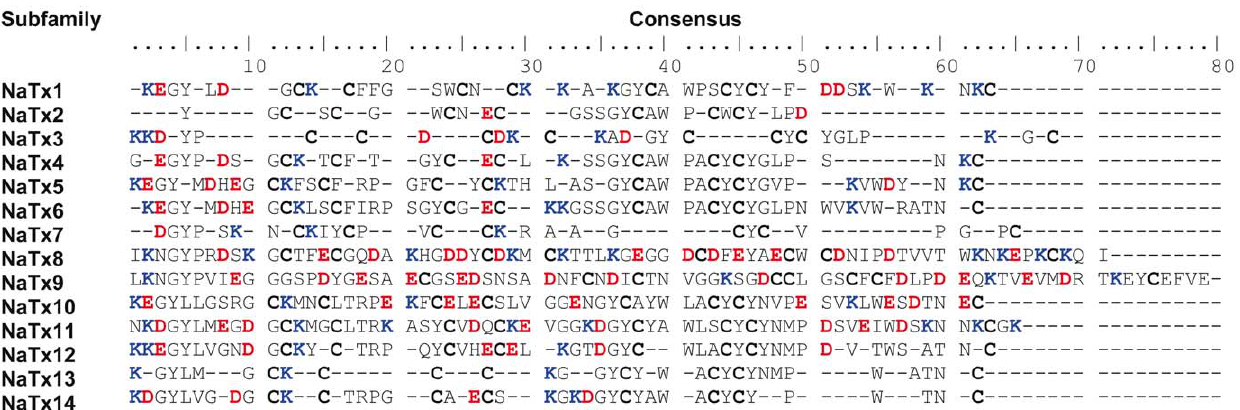
Figure 5. Consensus sequences for the 14 proposed subfamilies of NaTxs from scorpions of the genus Tityus . Amino acid sequences were obtained by classical proteomic approach and/or predicted by cDNA library constructions from scorpion venom glands. Acidic and basic residues are shown in red and blue, respectively. Cys residues are shown in bold.